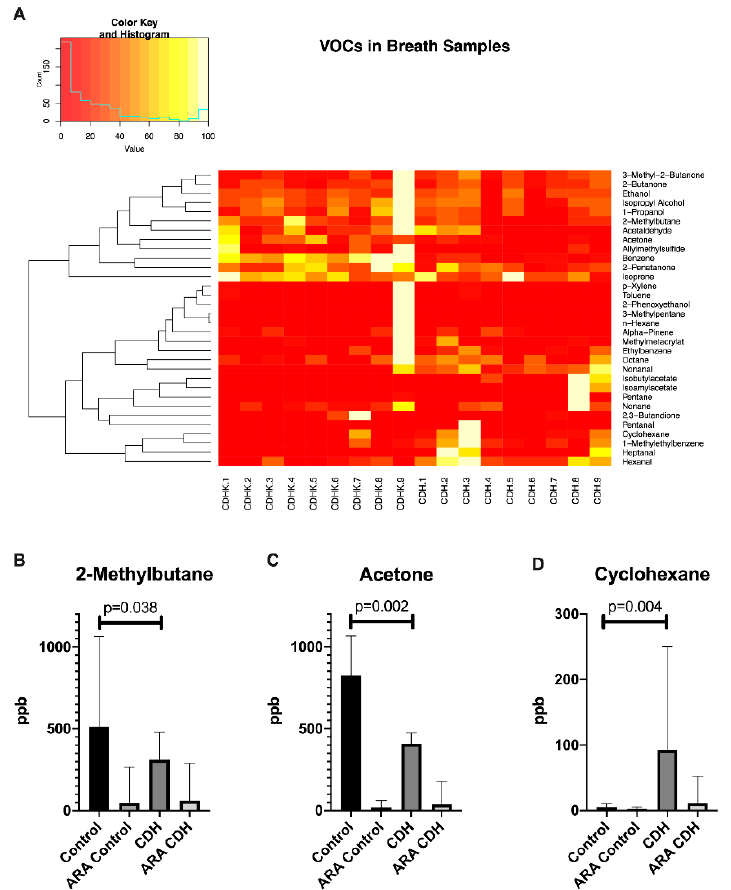
Figure 1. Concentrations of selected VOCs in breath samples of control patients and CDH patients ( A ). Concentrations of 2-methylbutane ( B ), acetone ( C ) and cyclohexane ( D ) were significantly different between the two groups; ARA: ambient room air.